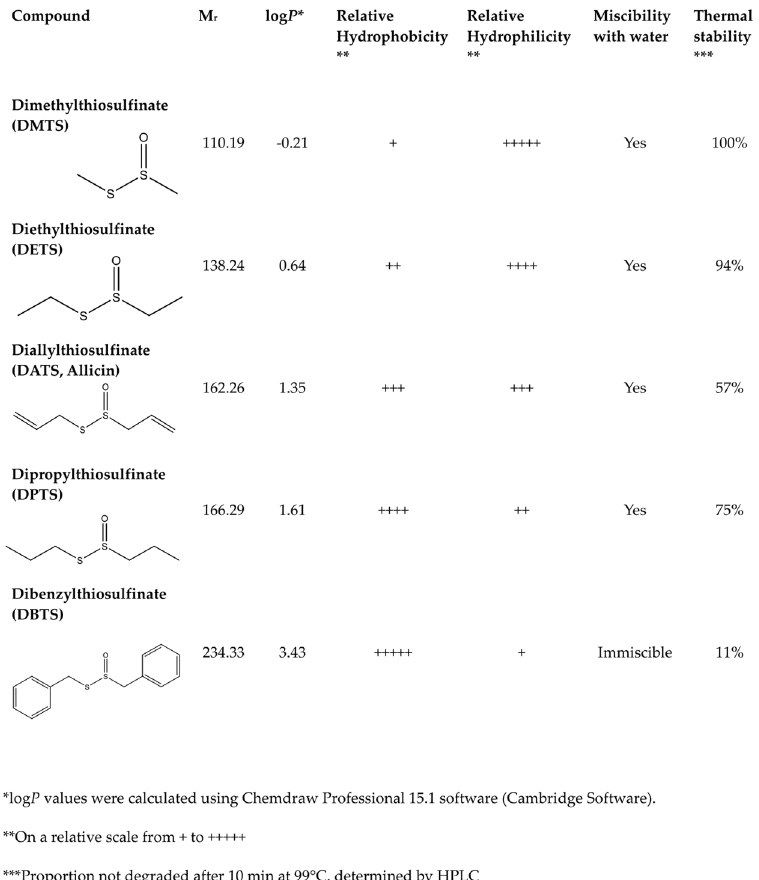
Figure 3. Physical properties of different